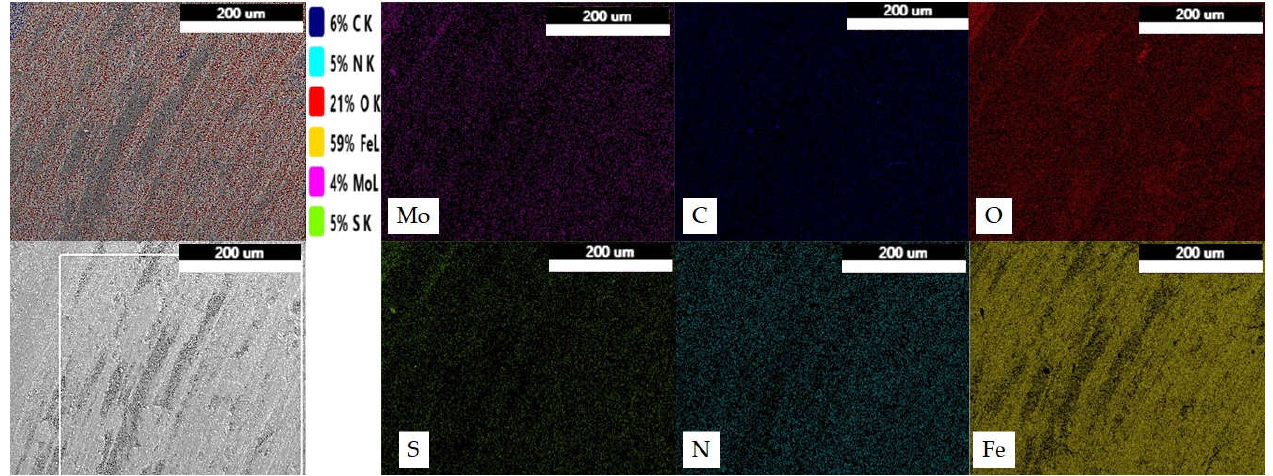
Figure 10. EDX elemental mapping of MoS 2 -coated disc after wear test at 15 N applied load and 0.75 m/s sliding speed.